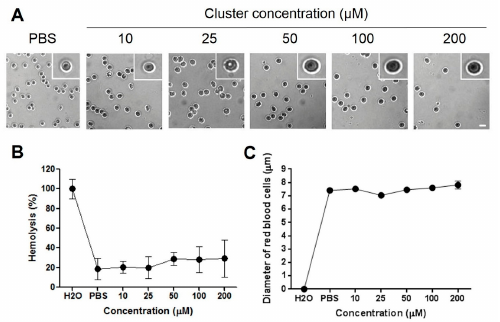
Figure 4. Hemolysis and morphology of human red blood cells after delayed exposition (24 h) to increasing concentrations of the cluster. ( A ) Representative pictures of red blood cells at different cluster concentrations are shown. Exposition to 200 µM of the cluster induces slight crenation of red blood cells, compared to controls; ( B ) Hemolysis was similar to control (PBS) through all concentrations; ( C ) The average size of erythrocytes is similar in all concentrations. Scale bar: 10 µm.